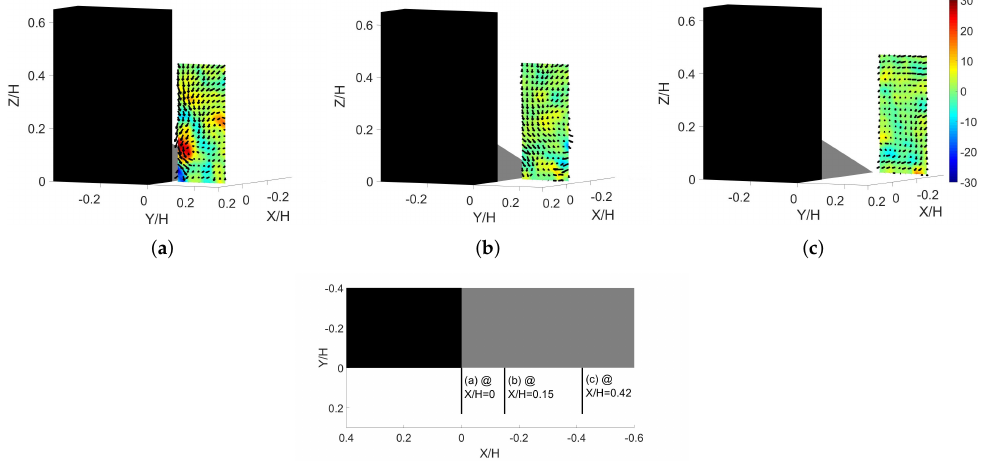
in representative X